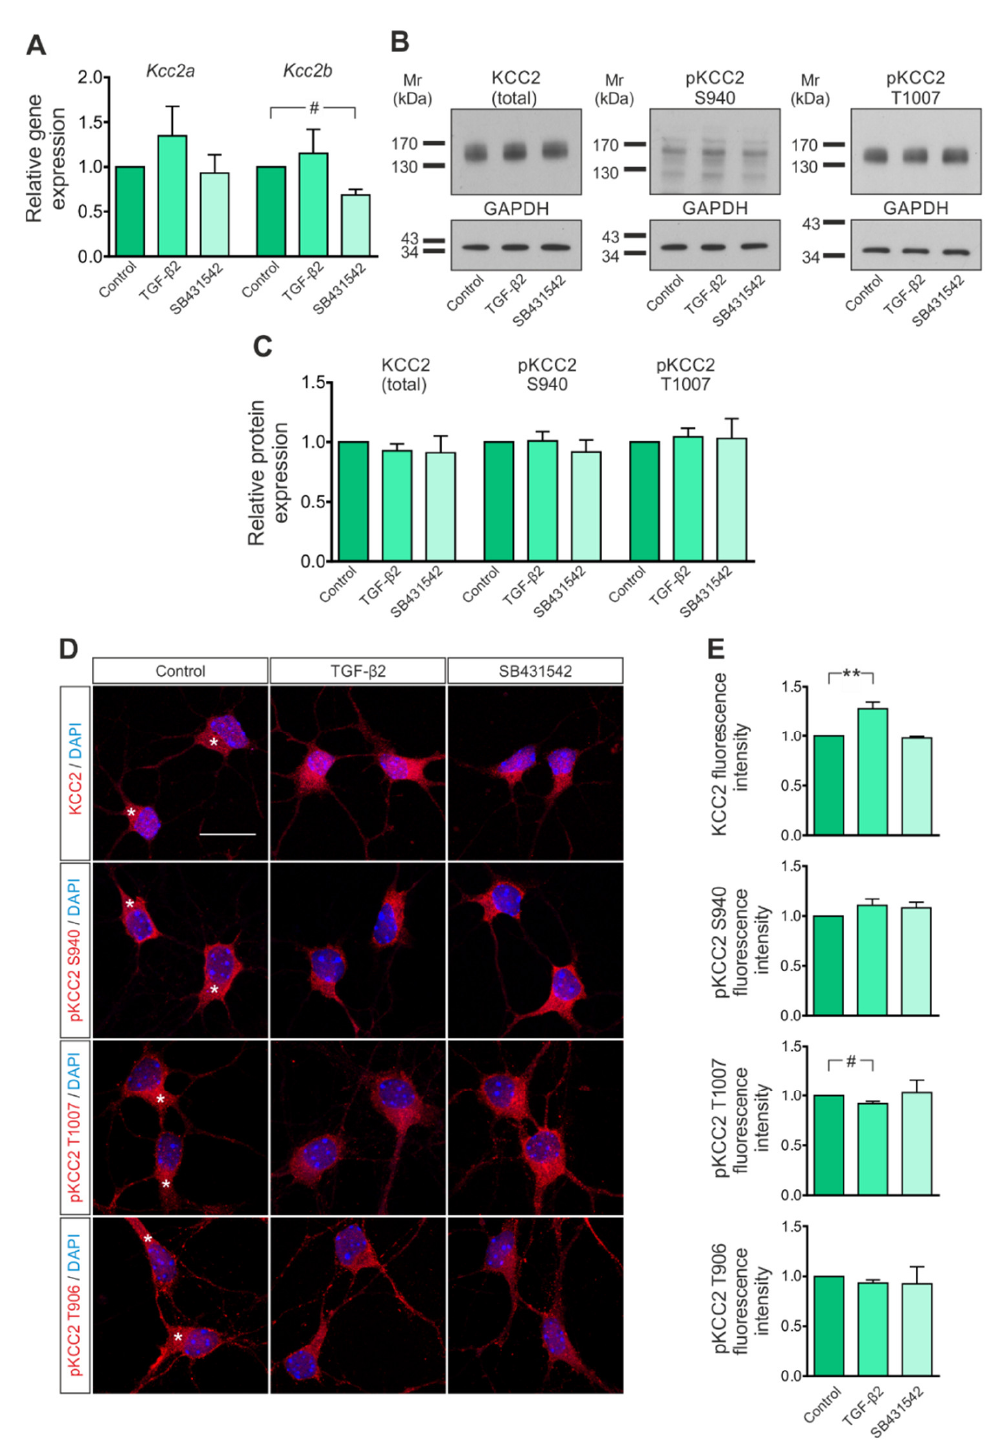
Figure 1. Regulation of Kcc2 transcript and KCC2 protein in immature mouse hippocampal neurons by TGF-β/activin signaling. ( A ) Quantitative RT-PCR analysis for the splice variants Kcc2a and Kcc2b on cDNA from primary immature mouse hippocampal neurons treated with either TGF-β2 (2 ng/mL) or 10 µM SB431542 (an ALK4/5/7 inhibitor) for 60 min ( # p < 0.05 for significant decrease compared to controls, using the two-tailed unpaired Student’s t -test with Welch’s correction, n = 4– 6). ( B ) Representative blots and ( C ) quantification of protein abundance of total and phosphorylated (p)KCC2 at S940 and T1007 by immunoblotting in control immature hippocampal neurons and fol- lowing treatment with 2 ng/mL TGF-β2 or the ALK4/5/7 inhibitor SB431542 (10 µM); not significant after densitometric analysis of the signal ratio protein of interest: GAPDH and two-tailed unpaired Student’s t -test with Welch’s correction, n = 5). A total of 20 µg protein was loaded per lane. ( D ) Immunofluorescence confocal microscopy for KCC2 (red) and pKCC2 at S940, T1007 or T906 on mouse primary immature hippocampal neurons. Asterisks indicate intracellular KCC2 localization. Scale bar: 20µm. ( E ) Quantification of immunofluorescence intensity of total KCC2 and pKCC2 at